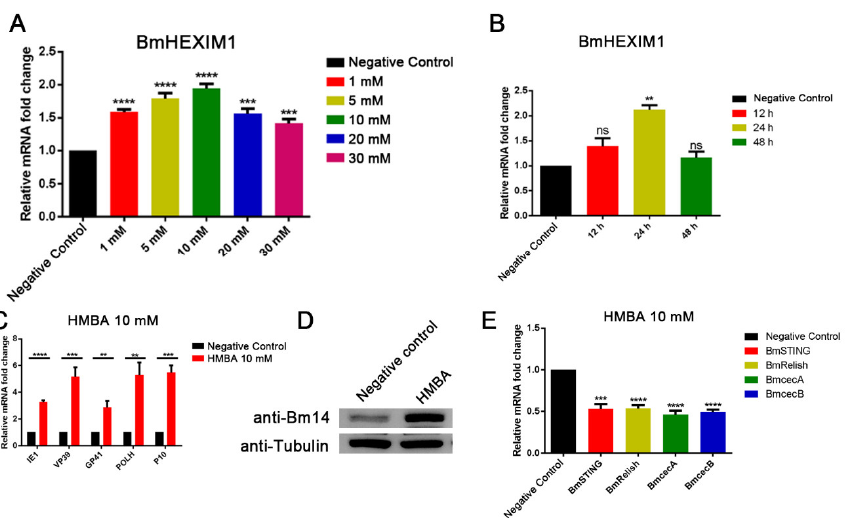
Figure 5. HMBA inhibited BmRelish-mediated pathway and promoted BmNPV proliferation. ( A ) BmN cells were stimulated with increasing concentrations of HMBA (1, 5, 10, 20, and 30 mM) for 24 h, and the expression levels of BmHEXIM1 were measured by qRT-PCR analysis. ( B ) BmN cells stimulated or not with HMBA (10 mM) for 12 h, 24 h, and 48 h and the expression of BmHEXIM1 were measured by qRT-PCR analysis. ( C ) BmN cells stimulated with HMBA (10 mM) for 24 h and the expression of viral genes were measured by qRT-PCR analysis. ( D ) BmN cells stimulated with HMBA (10 mM) for 24 h, and then added BmNPV for 48 h. BmNPV abundance was assessed by analyzing the expression of Bm14 by Western blot. ( E ) BmN cells stimulated with HMBA (10 mM) for 24 h and the expression levels of BmSTING, BmRelish, BmcecA, and BmcecB were measured by qRT-PCR analysis. The mRNA level of target genes was normalized to the internal control (BmRPL32). Data represent mean ± SEM of the three independent experiments. The number of asterisks represents the degree of significance with respect to p -value. p -values were provided as ** p < 0.01; *** p < 0.001; **** p < 0.0001.